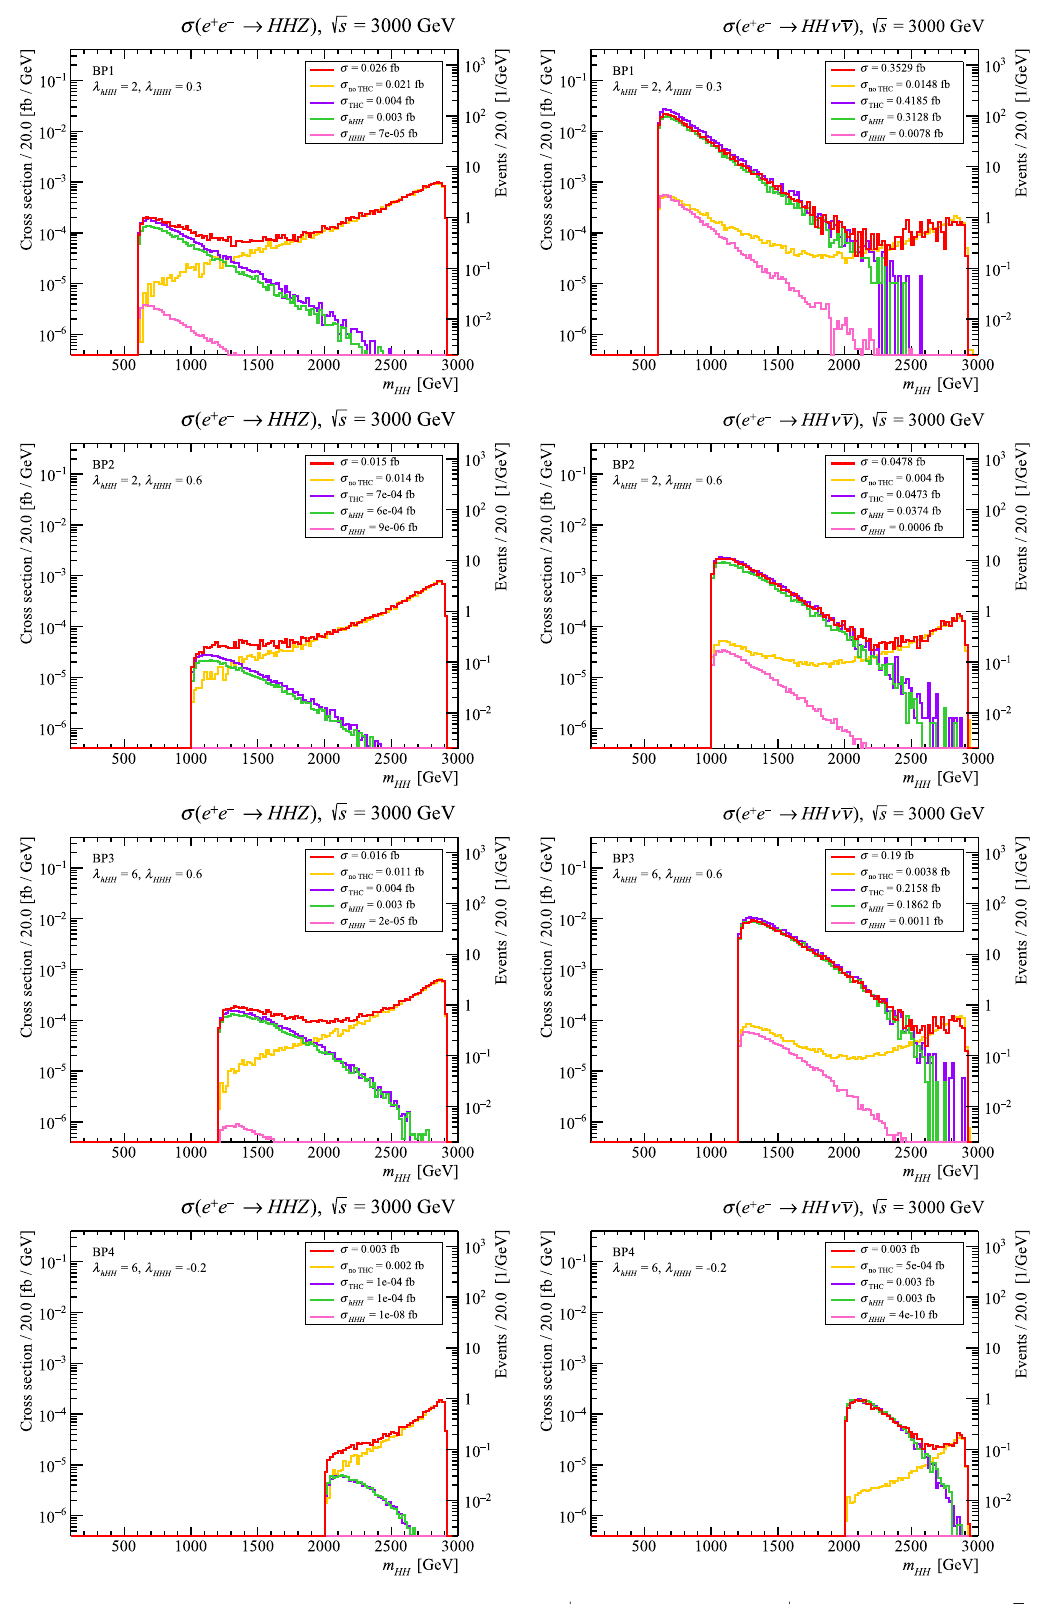
Fig. 28 Distributionontheinvariantmassofthefinal H H pairintheprocess e + e − → H H Z (left)and e + e − → H H ν ¯ ν (right)at for BP1, BP2, BP3 and